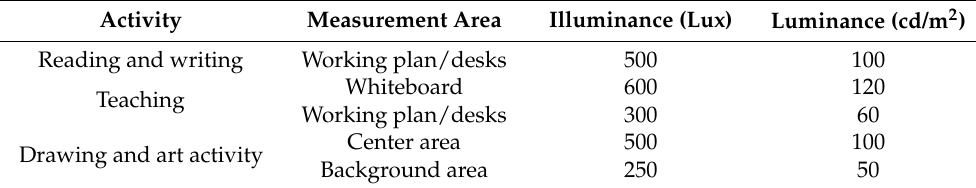
Table 2. The luminance values required for each activity.